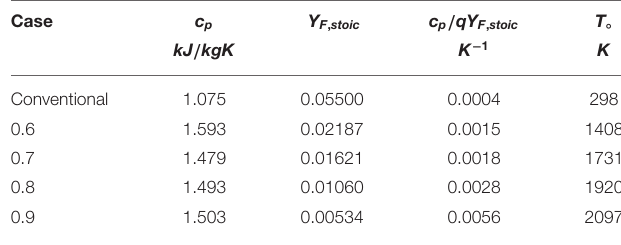
TABLE 1 | Quantities relating to the counterflow systems in Sidey and Mastorakos (2016) relevant to the critical phenomena condition (Equation 20). Case